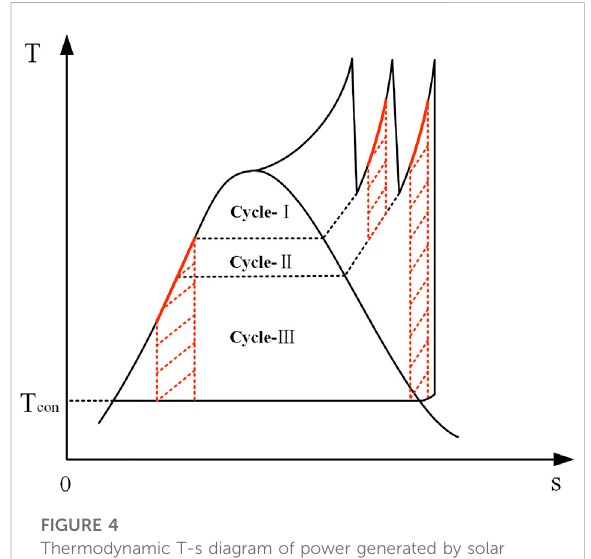
FIGURE 4 Thermodynamic T-s diagram of power generated by solar energy